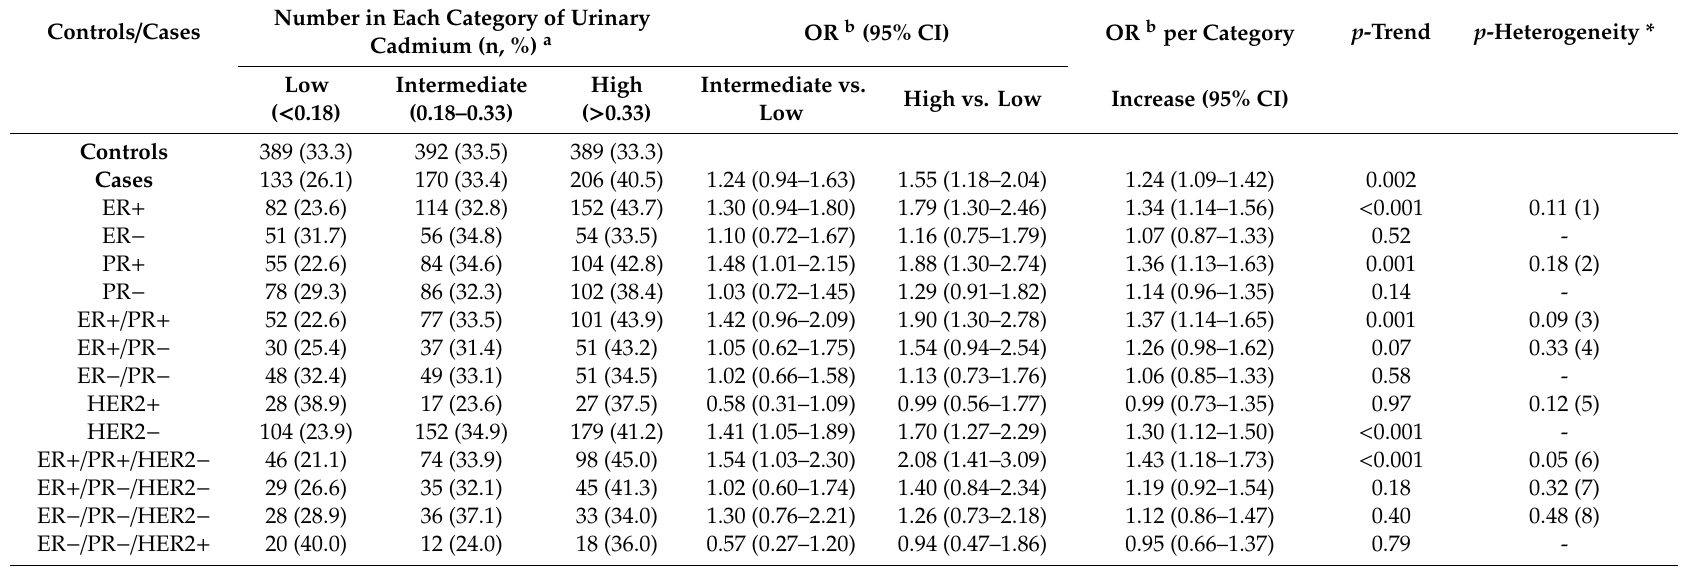
Table 2. Odds ratios (ORs) and 95% confidence intervals (CIs) for the association of creatinine-adjusted urinary cadmium (kg × 10 − 9 / kg × 10 − 3 creatinine) with breast